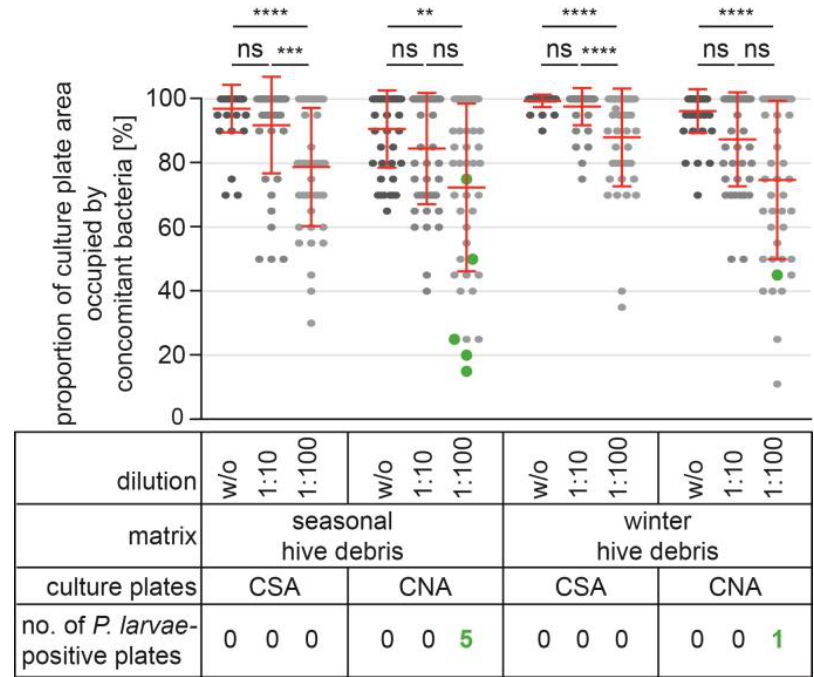
Figure 3. Reducing the impact of concomitant bacteria in debris samples by sample dilution. Samples of seasonal and winter hive debris were spiked with four different amounts of P. larvae spores (125,000 spores, 12,500 spores, 1250 spores, and 125 spores; non-spiked samples served as controls) and cultured on CSA and CNA plates either without dilution (w/o) or after being diluted at a ratio of 1:10 or 1:100. Colonies of P. larvae were identified, and the proportions of the culture plates occupied with concomitant bacteria were estimated. Scatter plots show 45 samples per undiluted or diluted sample and culture medium, analyzed by Kruskal–Wallis nonparametric testing with Dunn’s multiple comparisons test (ns, p > 0.05; **, p < 0.01; ***, p < 0.001, ****, p < 0.0001). In addition, mean values ± SDs of the 45 independent samples are given. The P. larvae -positive plates are marked in green.